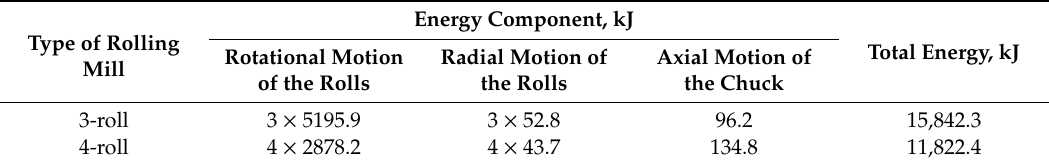
Table 1. Energy required to form solid axles.